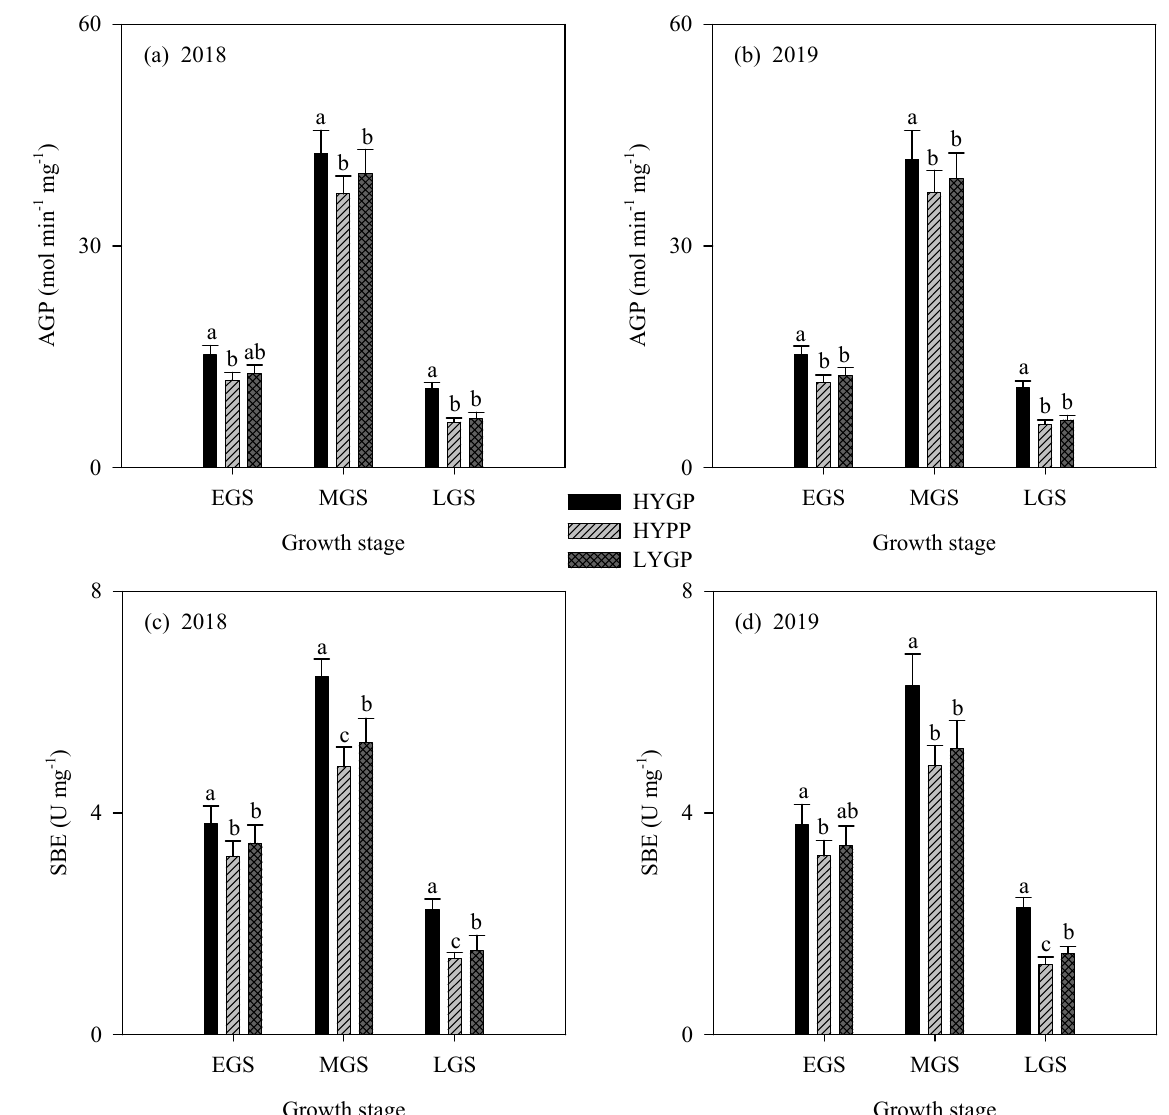
Figure 4. AGP ( a , b ) and SBE ( c , d ) activities in the grains after the heading of rice cultivar types. AGP, adenosine diphosphate glucose pyrophosphorylase; SBE, starch branching enzyme; HYGP, high-yielding rice with good palatability; HYPP, high-yielding rice with poor palatability; LYGP, low-yielding rice with good palatability; EGS, early grain-filling stage; MGS, middle grain-filling stage; LGS, late grain-filling stage. Different lowercase letters in the same growth stage above the histogram indicate statistical significance at the p < 0.05 level.